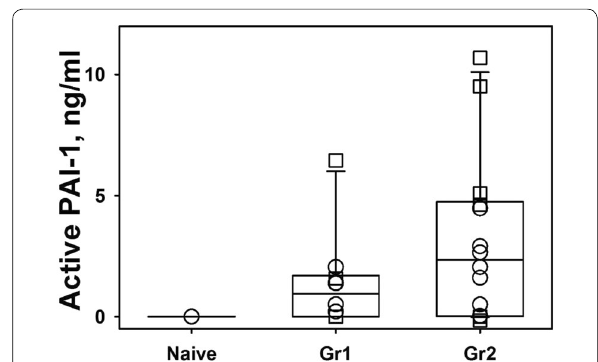
0.02). No statistically =